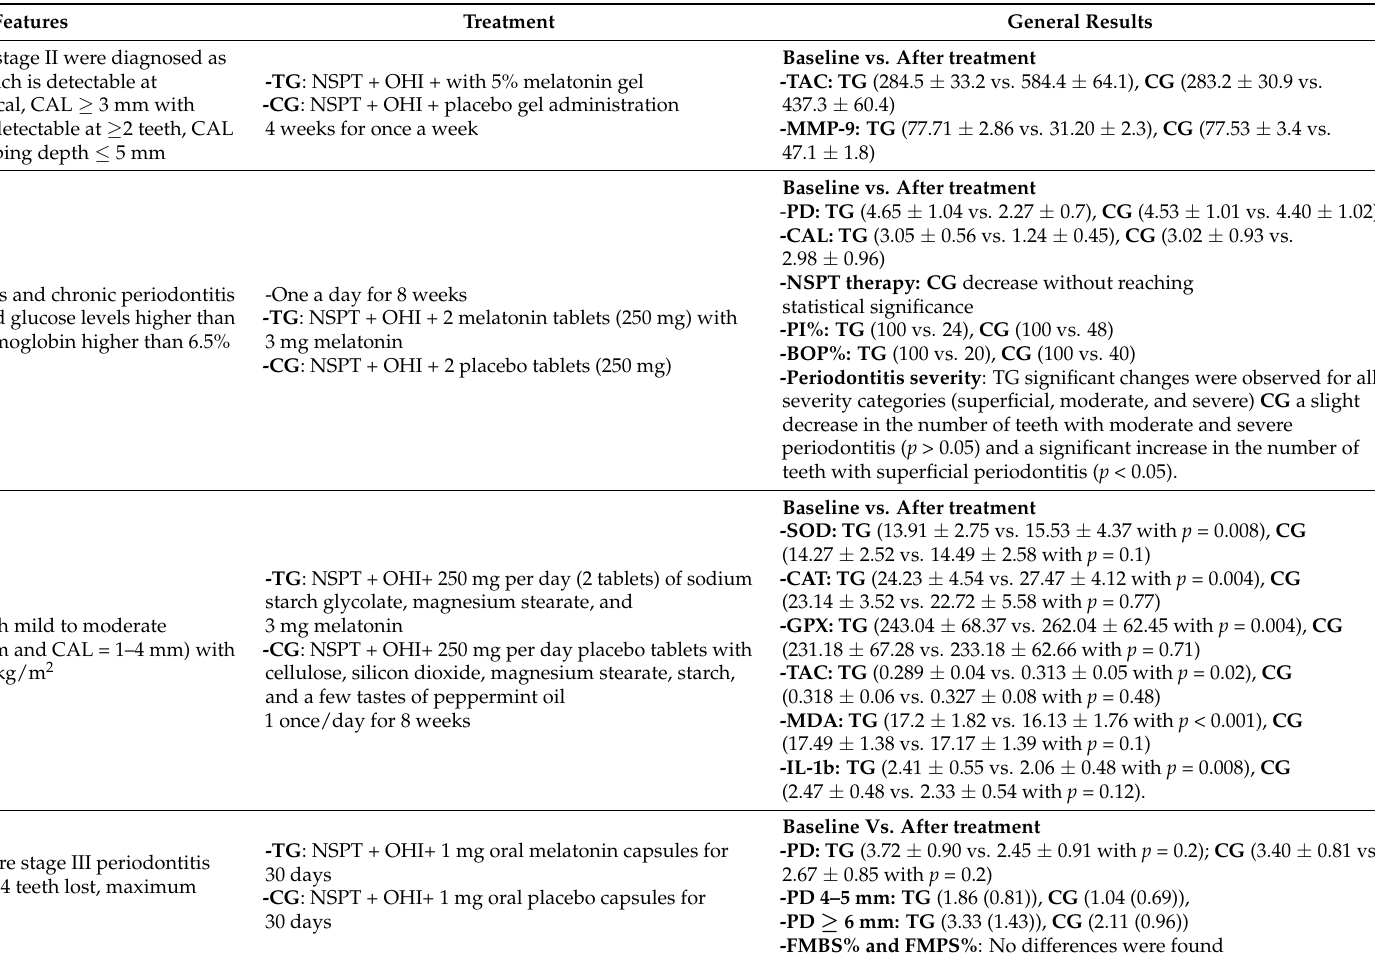
Table 3. General data and results of the included